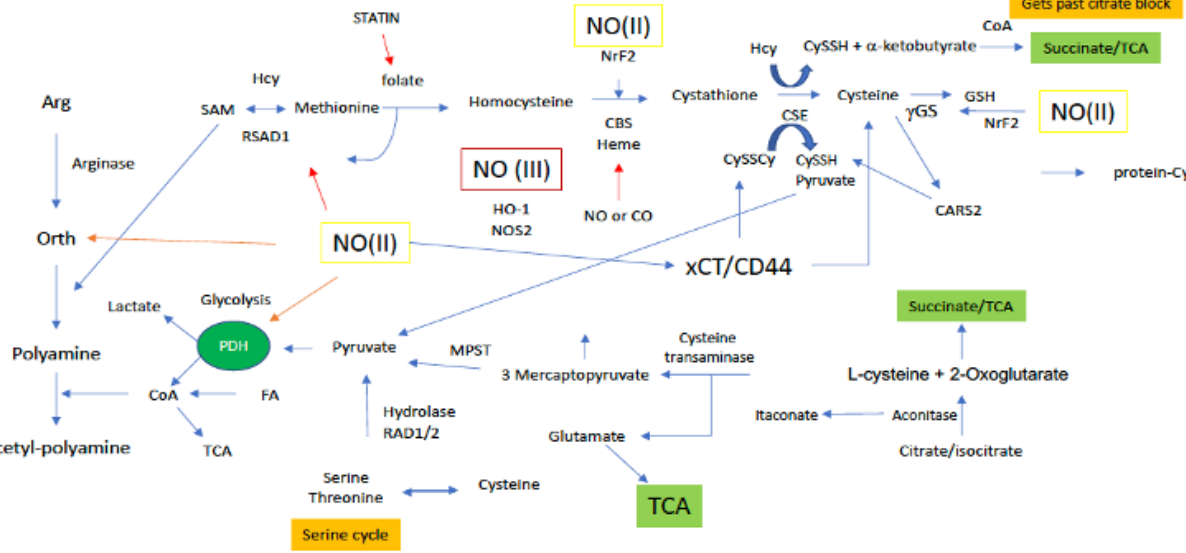
Figure 4. Sites along arginine and sulfur metabolic paths for NO interaction. Green boxes/(II) represent intermediate levels of NO (nitrosative signaling) and red boxes/(III) indicate high levels of NO (nitrosative stress) required for NO interaction at the indicated site. Red arrows indicated inhibitory mechanisms while blue arrows indicate activating mechanisms.